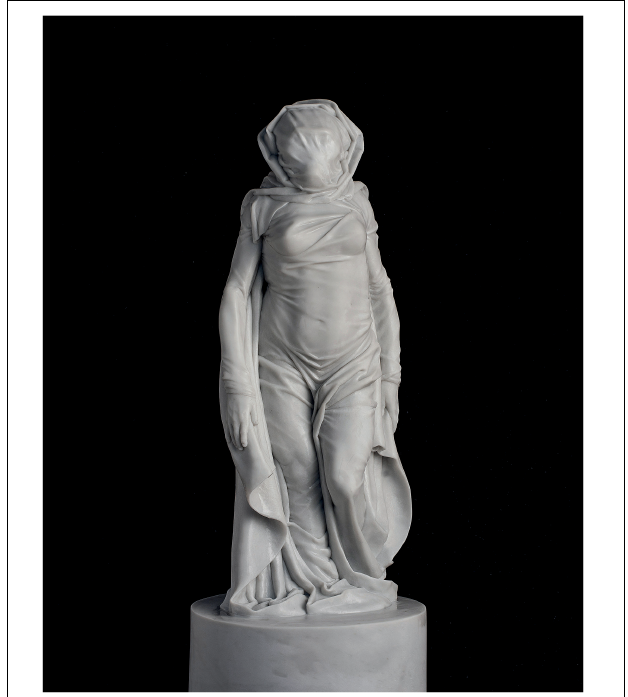
FIGURE 8 | A marble sculpture titled “Santa Lucia” carved in 2019 following the body-composition of the intuitive reconstruction of Lucy previously shown in Figure 2